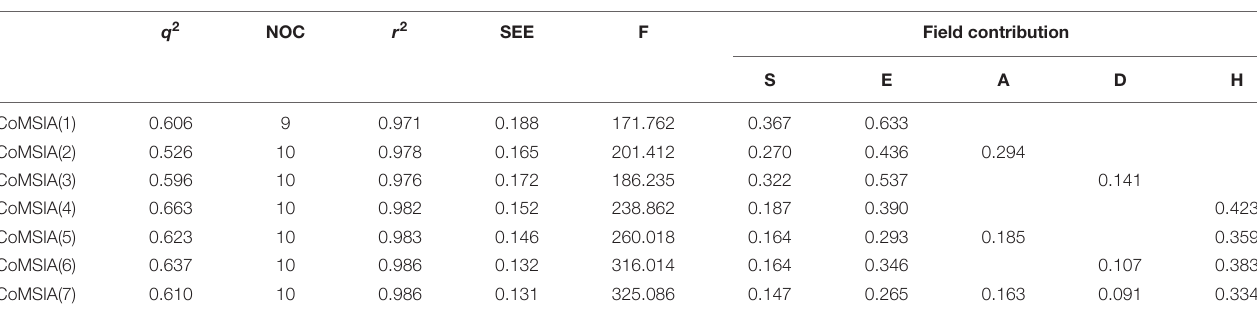
TABLE 2 | Detailed results of CoMSIA models generated on several field